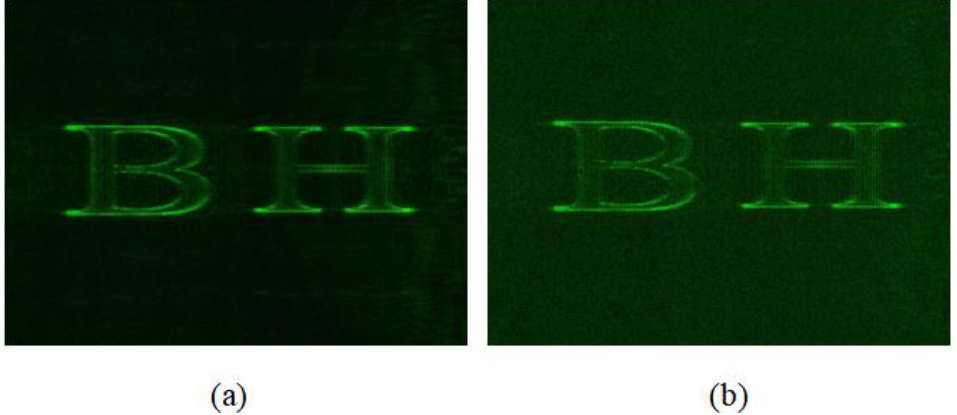
Figure 5. Simulation result of the reconstructed image. ( a ) Result by using the proposed system with loading DOEs; ( b ) result without loading the DOEs.